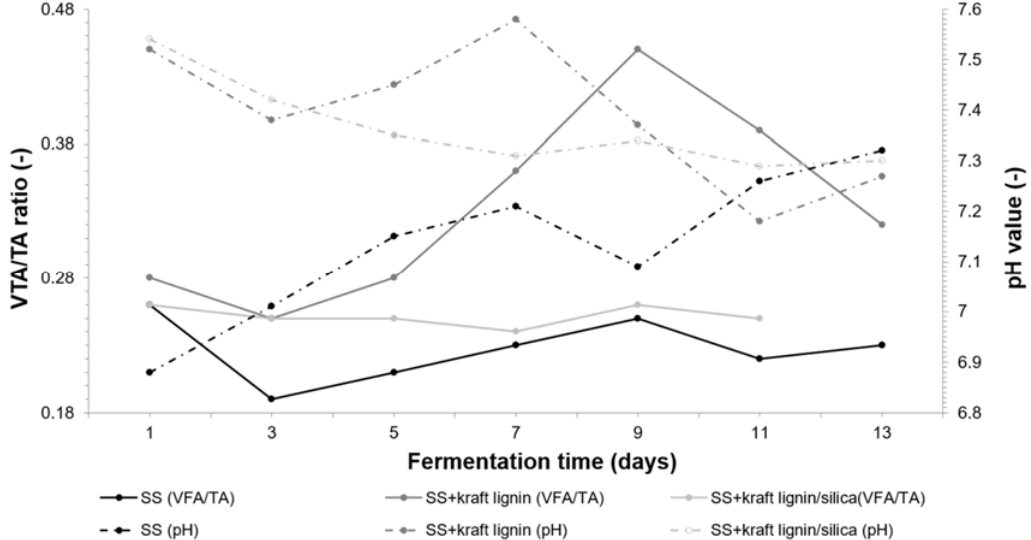
Figure 13. Changes in pH and the VFA / TA ratio during the anaerobic digestion of the SS, SS + kraft lignin and SS + kraft lignin / silica samples.